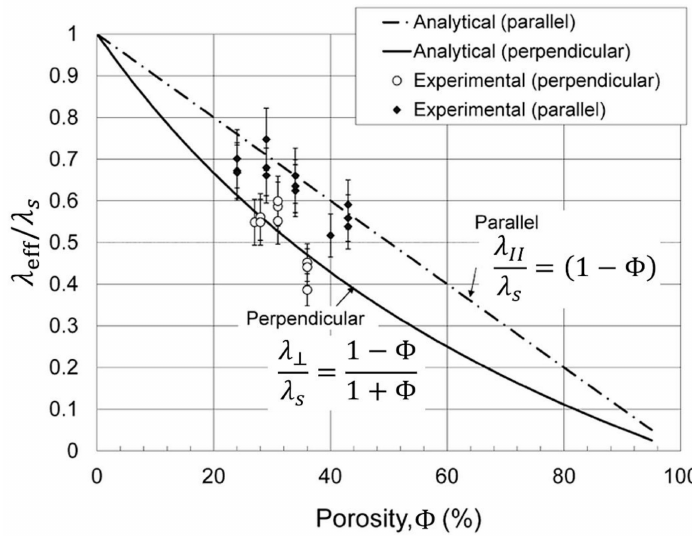
Figure 6. Heat conductivity of lotus-type structures in parallel and perpendicular direction of the pores